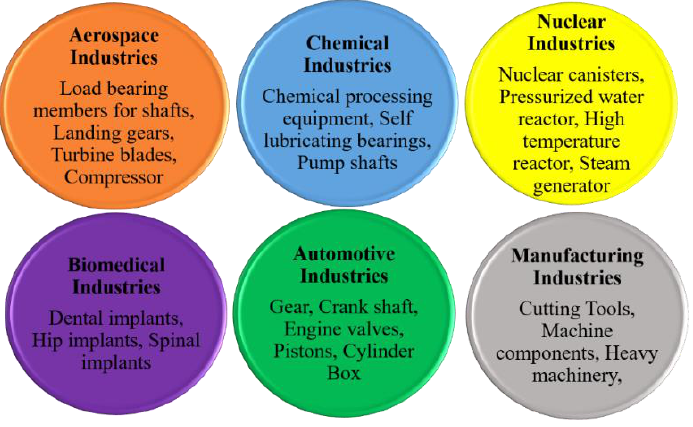
Figure 16. Applications of USRP in various industries.